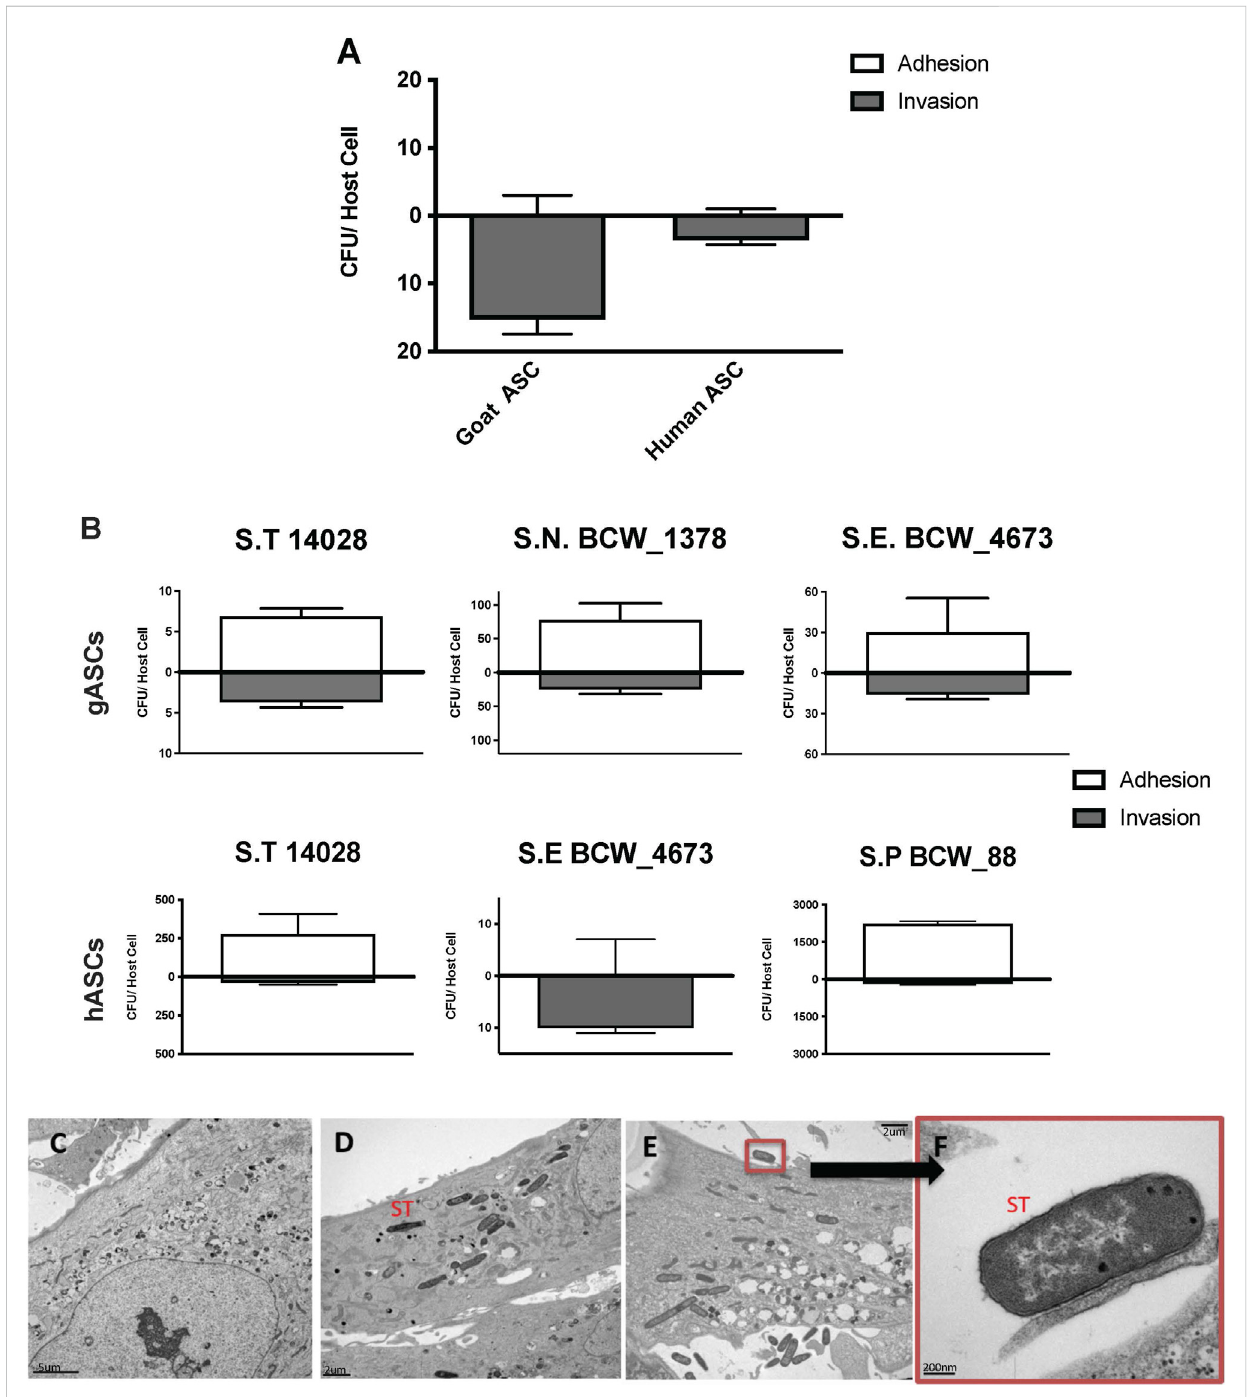
FIGURE 1 Microbial Association with human and goat ASCs (A – F) . ASCs presented a uniform pattern of Salmonella enterica ssp enterica serotype Typhimurium LT2 (ST) infection, the total associated bacteria were invaded, gASC show signi fi cantly higher invasion compared to human cells (A) . ASCs susceptibility to invasion was not exclusive to ST, association patterns were microbe speci fi c; 35%, 12% Salmonella enterica ssp enterica serotype Typhimurium 14,028, and 25%, 100% Salmonella enterica ssp enterica serotype Enteritidis (BCW_4673) were invaded in goat and human ASCs respectively (B) . In gASCs, 35% Salmonella enterica ssp enterica serotype Newport (BCW_1378) and in hASCs, 7% of Salmonella enterica ssp enterica serotype Saint Paul (BCW_88) were invaded (B) . Intracellular ST was observed by TEM 2 h post MSC co-incubation (D – F) , consistent with control non- treated hASCs (C) , ST infected cells showed no signs of cellular toxicity (D – F) . ST adherence to hASC was observed at various sites (E – F)